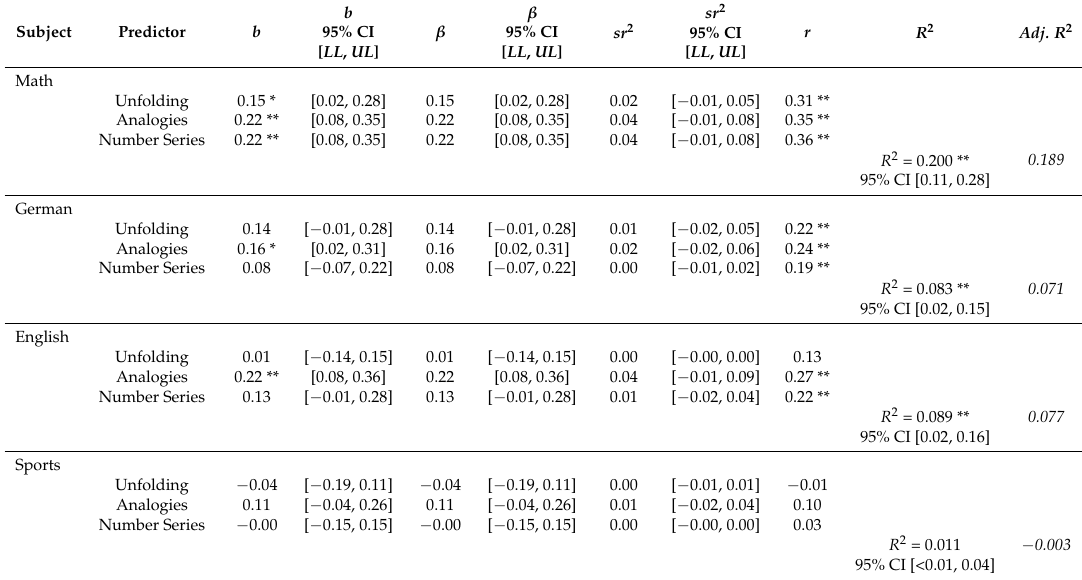
Table 3. Regression results using the different grades as criteria and the specific abilities as